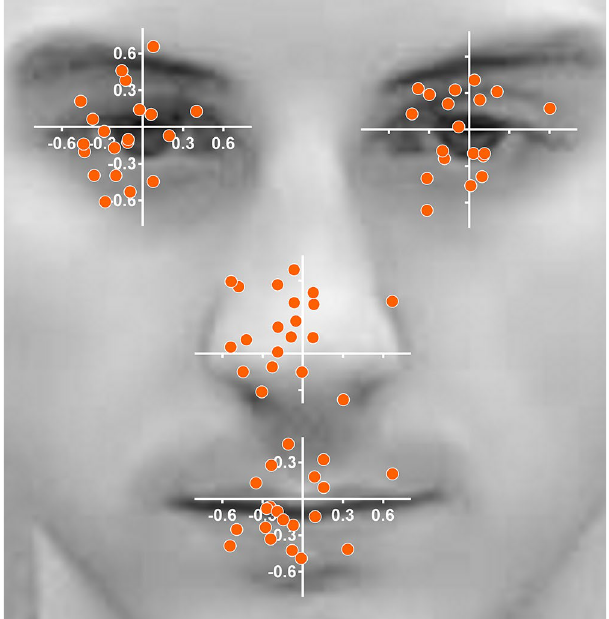
Figure 4. Illustration of individual accuracy for fixations on the eyes, nose and mouth. Data is presented for the 3D stimulus and the second run. Dots represent the average gaze points of a single participant over three repetitions fixating at a specific target (see “Methods” for details). The scale represents degrees visual